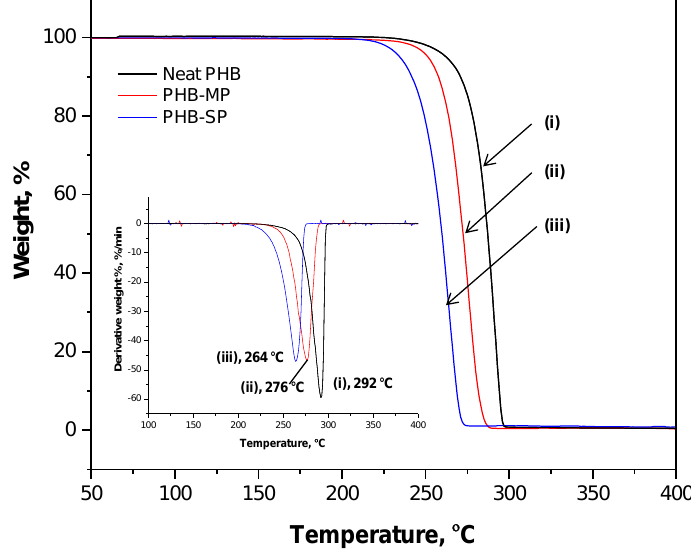
Figure 2. Thermogravimetric analysis (TGA) representing weight loss and differential weight loss (inset) curves of (i) neat PHB, (ii) PHB-MP and (iii) PHB-SP.